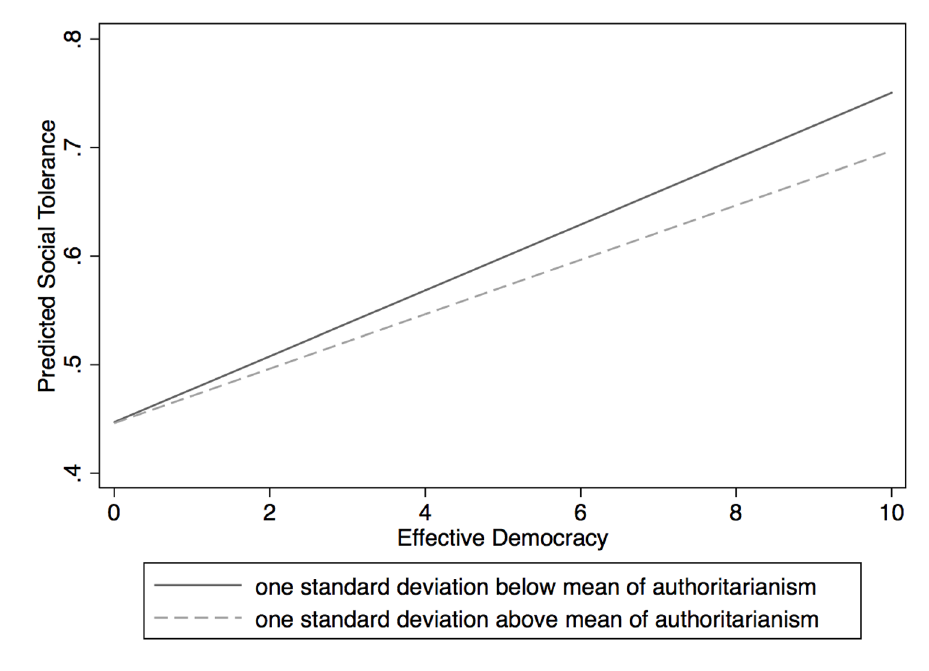
Figure 3. The effect of authoritarianism on social tolerance, conditional on effective democracy.